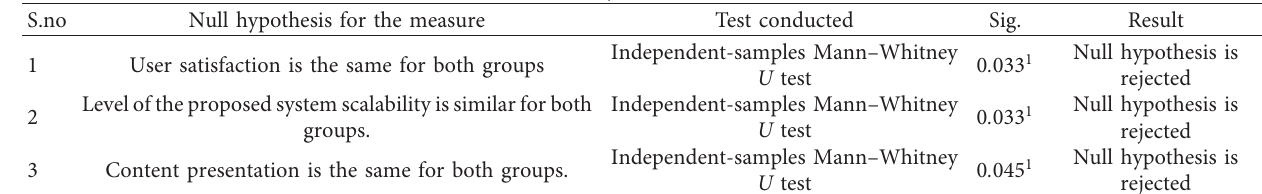
Table 11: Analysis of user satisfaction.